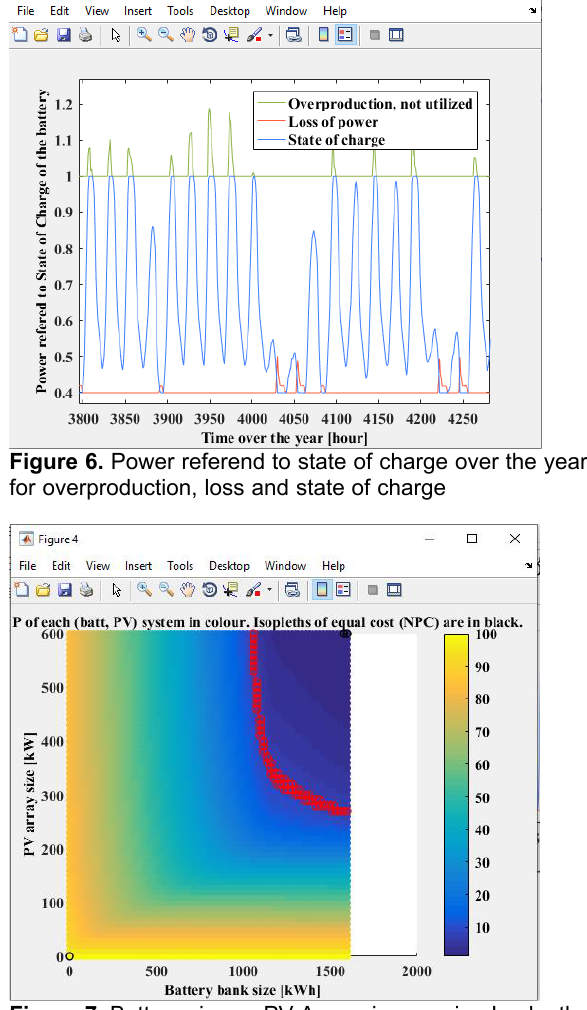
Figure 7. Battery size vs PV Array size causing Isodepth of equal cost NPC in black